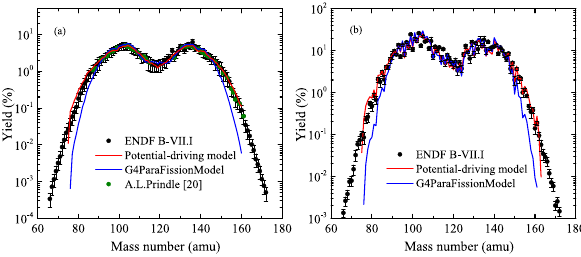
Figure 2. (color online). The comparison between the simulated data and the recommended data. The mass chain yield versus mass number for (a) independent yield and (b) cumulative yield of 241 Am(n,f) reaction. The red lines denote calculated results from the potential-driving model, the blue lines denote calculated results from G4ParaFissionModel [19], and the color dots and black dots denote experimental and evaluated data,